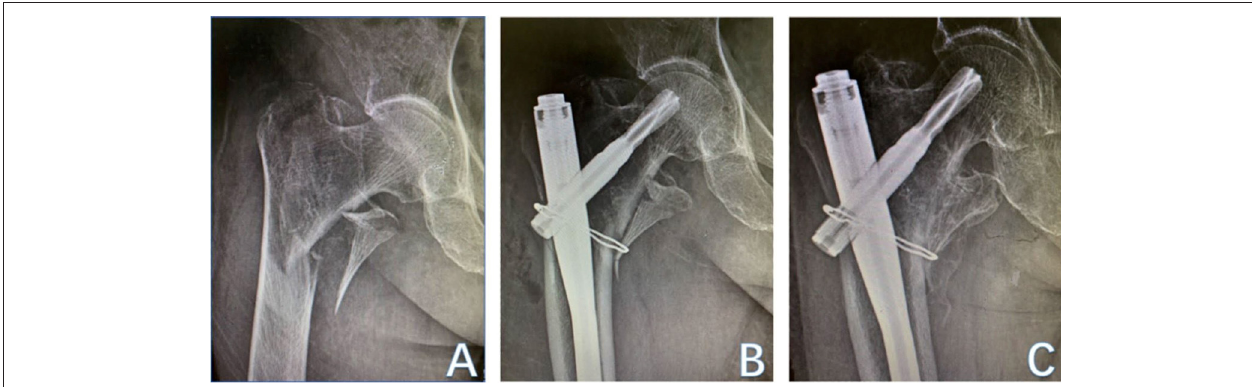
FIGURE 1 | An 81-year-old woman suffered from trochanteric fracture with displaced LT (A) . Ten days later, she underwent operation of PFNA and cerclage wire (B) . The follow-up after 5 months implied LT union (C) .